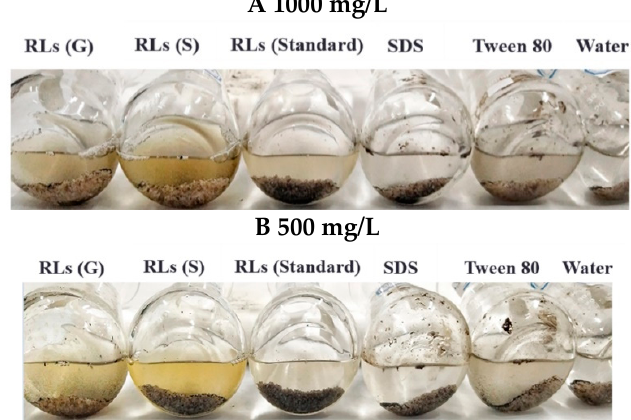
Figure 5. Bottom view of the oil sands after oil-washing by surfactants. The oil sands were treated with the surfactant solutions for 24 h at 70 °C and 90 rpm ( A , B ). RLs (glycerol) refer to the rhamnolipid products from glycerol; RLs (Soybean oil) refer to the rhamnolipid products from soybean oil. RLs (G) means rhamnolipids products from glycerol; RLs (S) means rhamnolipids products from soybean oil.